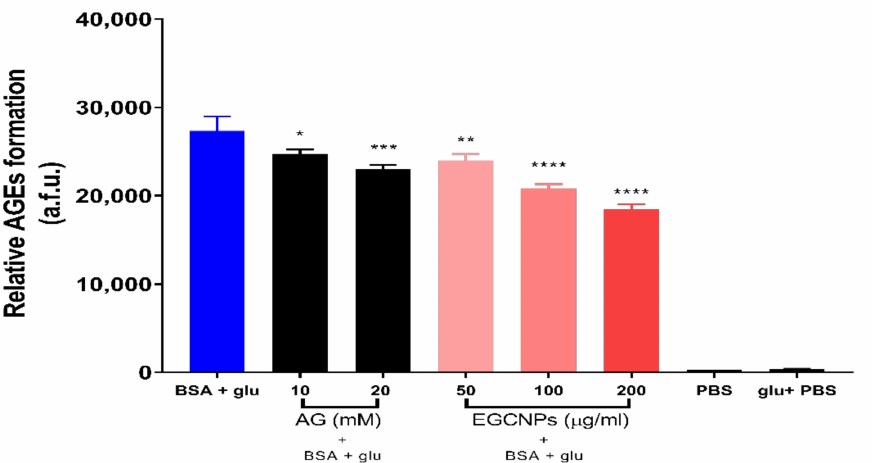
Figure 5. Effect of EGCNPs on the inhibition of the formation of advanced glycation end products (AGEs) for bovine serum albumin (BSA) when incubated with glucose (glu) for 72 h. For comparison, two concentrations of aminoguanidine (AG) were used as it is known for its antiglycation actions. For- mation of AGEs was measured by spectrofluorometry using a plate reader at ex/em = 300/400 nm. Asterisks denote statistical significance from BSA + glu, ( n = 3, * p ≤ 0.05, ** p ≤ 0.01, *** p ≤ 0.001 and **** p ≤ 0.0001, one-way ANOVA). Error bars are presented as means ±